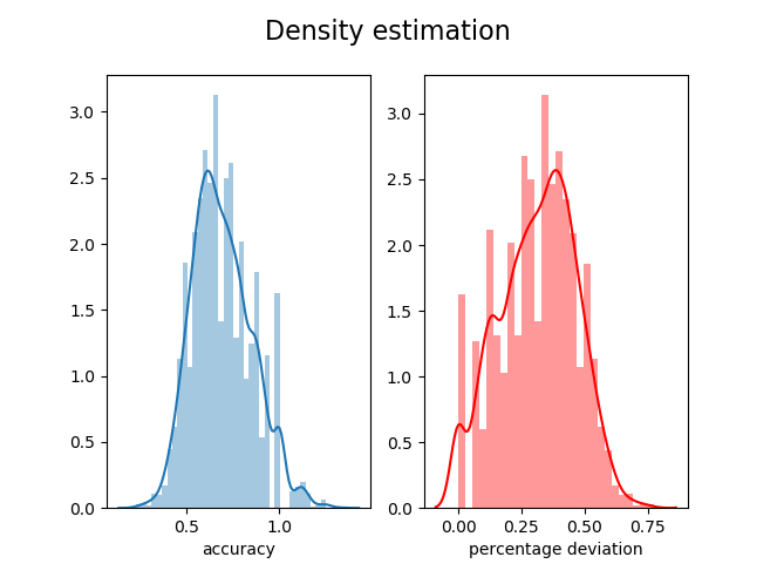
Figure 9. Kernel density estimation of the accuracy ( left ) and percentage deviation ( right ) computed across the 4500 frames of the Oxford